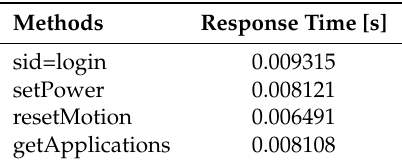
Figure 5. Simulation results of using the toolbox in a bin-picking task on the V-REP simulator. Table 2. Response times.